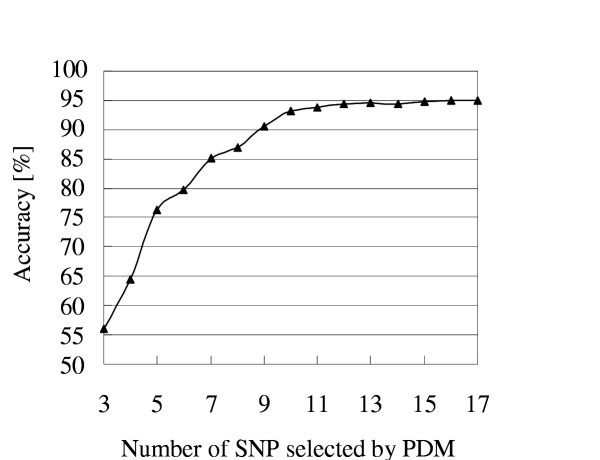
Reconstruction of ANN model using SNPs listed in Table 3. Closed triangles represent average accuracy for all data of learning and evaluation.